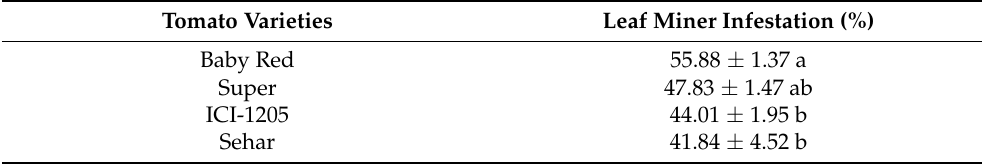
Table 4. Percent infestation of Liriomyza spp. on tomato